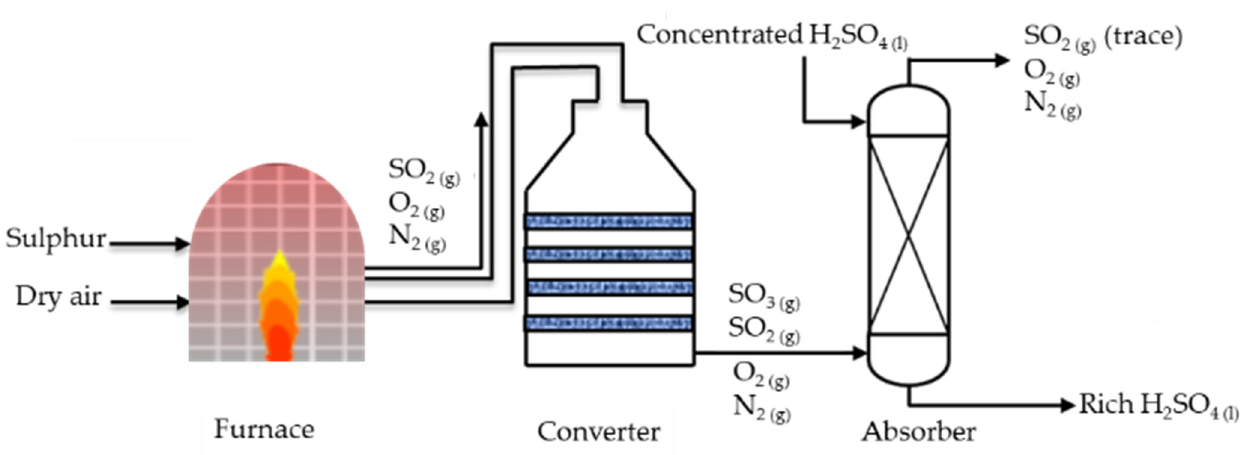
Figure 1. Simplified sulphuric acid production flowsheet showing the main three steps: (1) combustion of sulphur to produce SO 2 in presence of dry air, (2) oxidation of SO 2 to SO 3 in a series of adiabatic catalytic packed beds, and (3) absorption of sulphur trioxide in a concentrated sulphuric acid absorber and conversion to sulphuric acid.